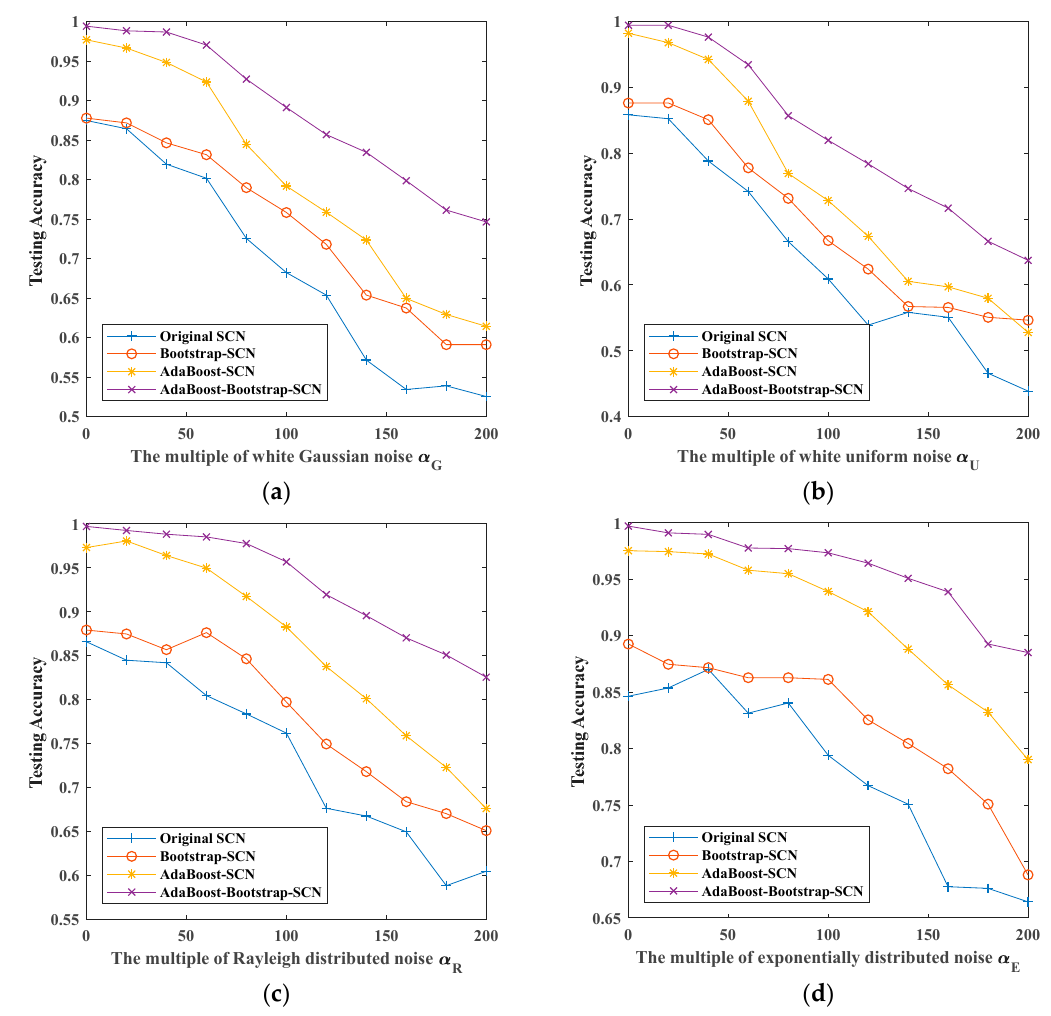
Figure 16. The maximum testing accuracy of different methods with different noises: ( a ) white Gaussian noise; ( b ) white uniform noise; ( c ) Rayleigh distributed noise; ( d ) exponentially distributed noise. Table 2. Performance comparison of different classifiers